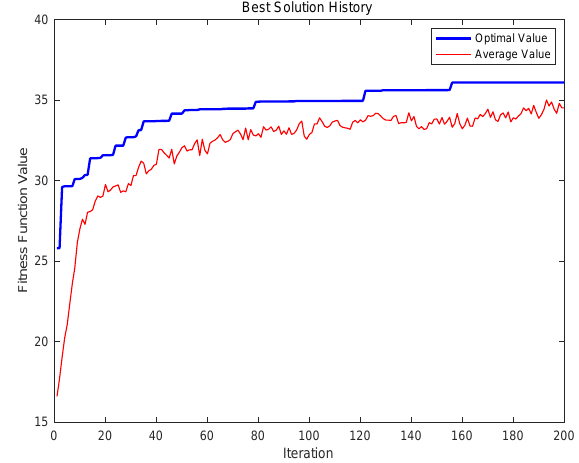
Figure 4. Evolution results of APGA with 28 attractions. Table 4. Results of the satisfaction route with APGA (28 attractions).